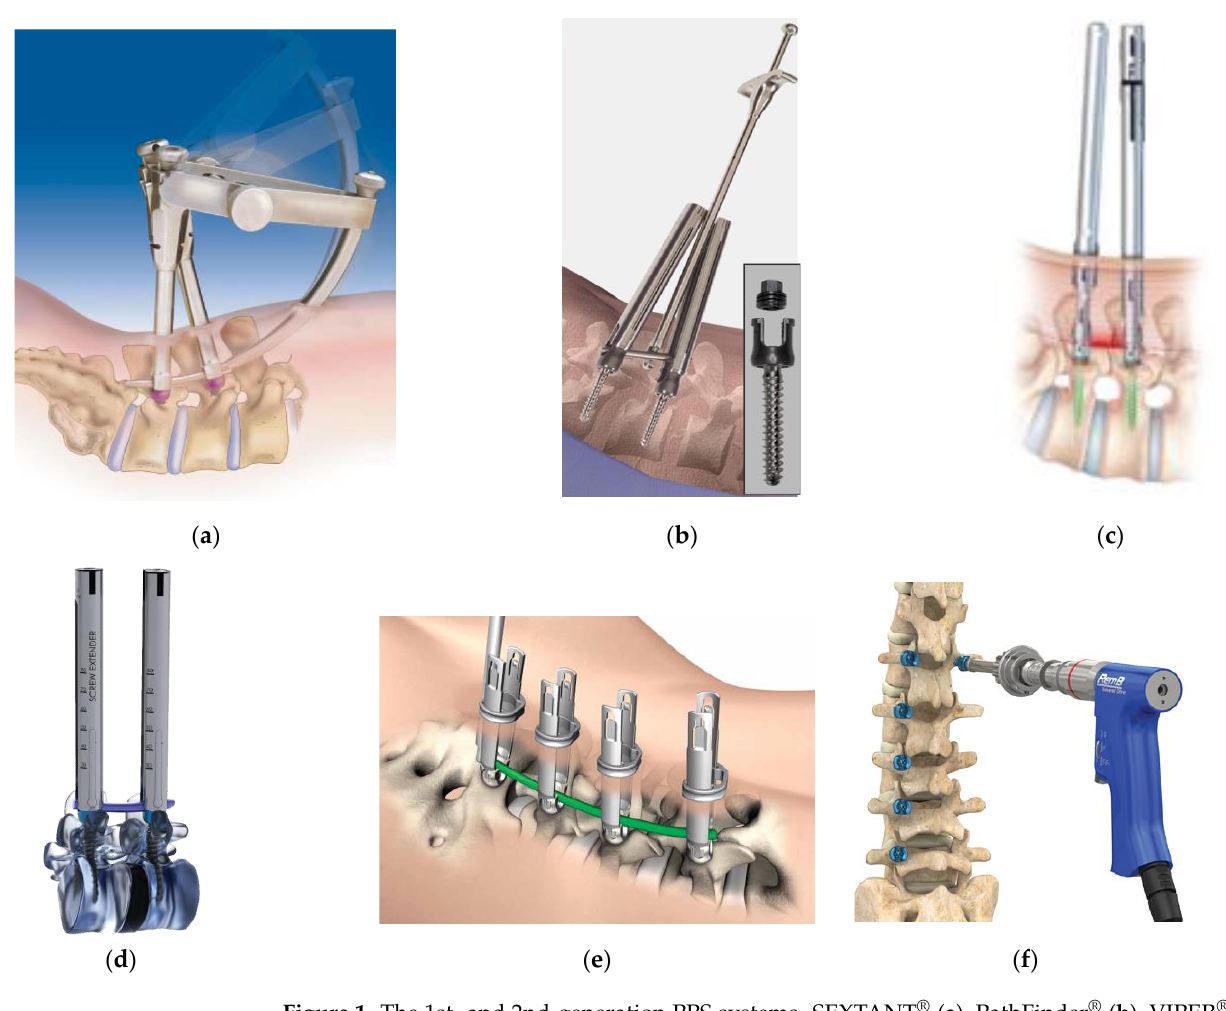
Figure 1. The 1st- and 2nd-generation PPS systems. SEXTANT ® ( a ), PathFinder ® ( b ), VIPER ® ( c ), ILLICO SE ® ( d ), MANTIS ® ( e ), and ES2 ® ( f ).